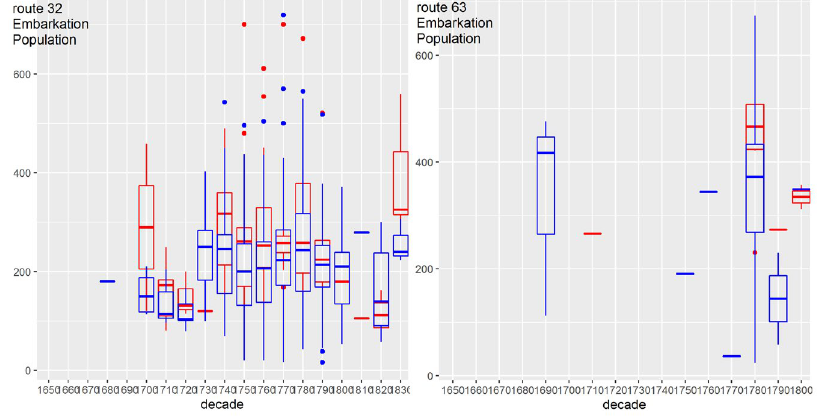
Figure 6a and 6b. Mean and sample distribution of voyages for two